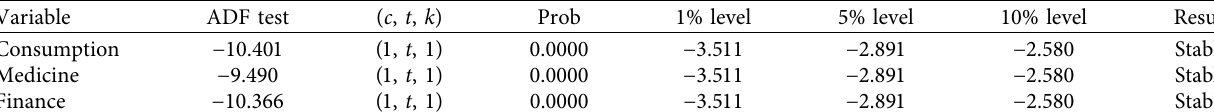
Table 4: Unit root test of variables.